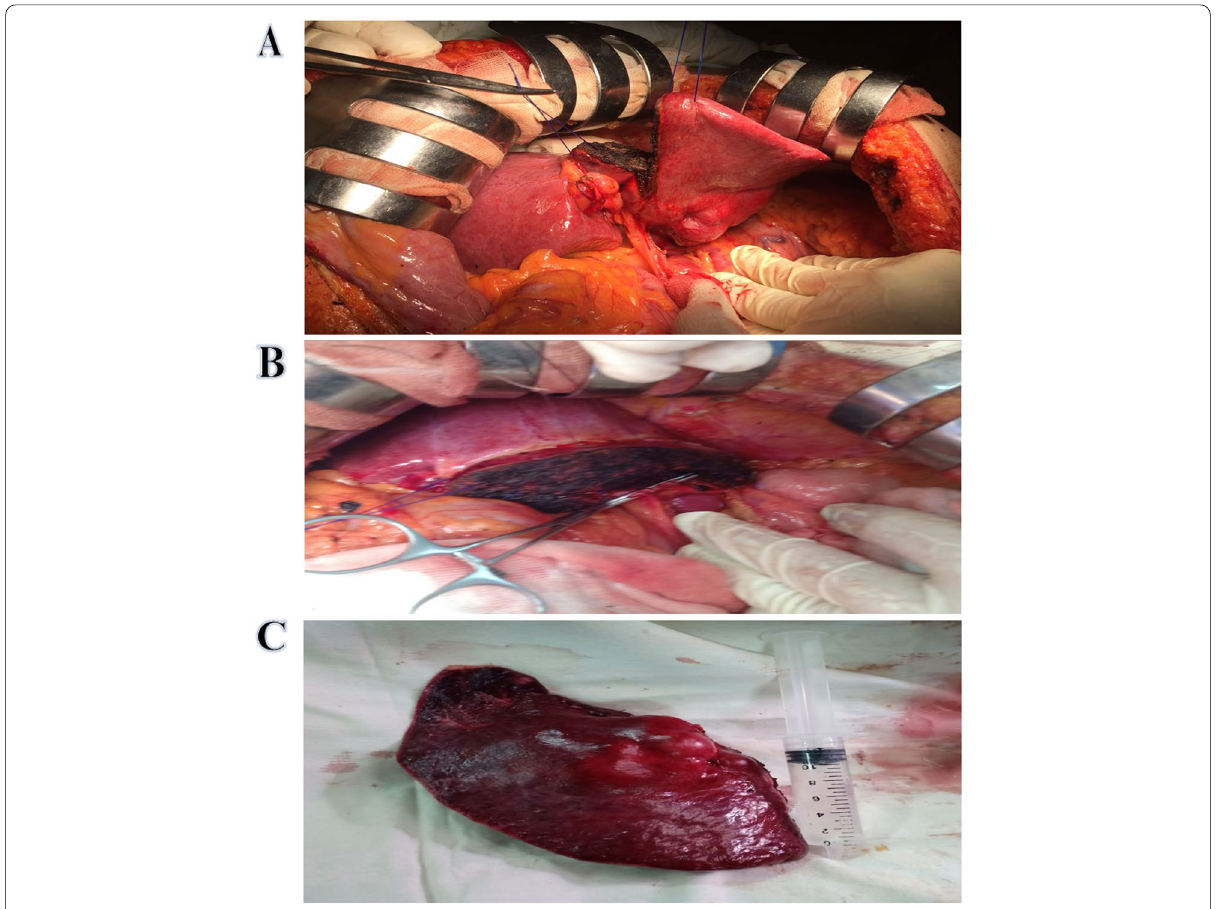
Fig. 2 A , B Operative images of left lateral sectionectomy for a segment 2, 3 HCC in one of the study patients. C Surgical specimen of the resected left lateral section of the